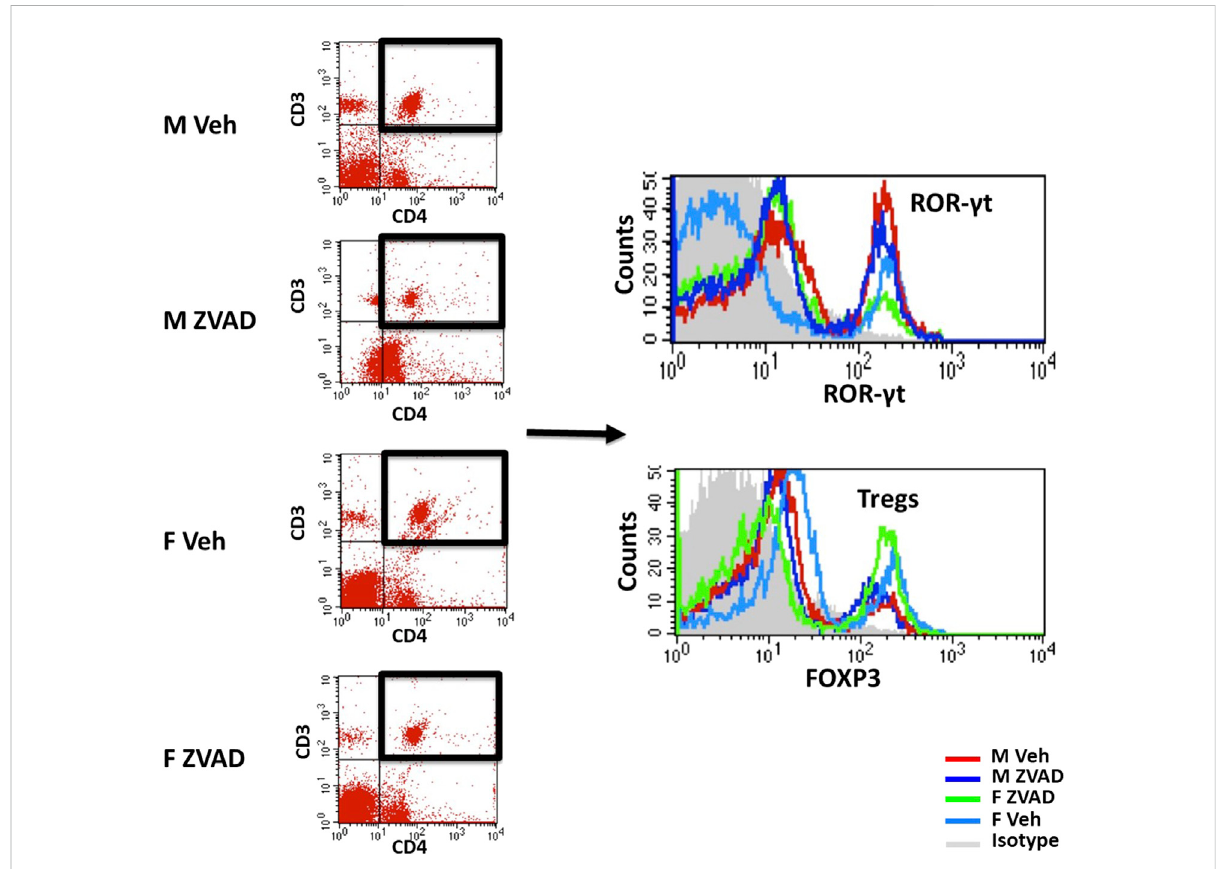
FIGURE 2 T cell pro fi les were analyzed by fl ow cytometry. Shown are representative scatterplots of fl ow cytometry gating strategy showing the selection of single cells and exclusion of cell debris based on forward scatter and side scatter. T cells were analyzed based on the expression of CD3 and/or CD4. Total CD3 + CD4 + T cells were further gated for expression of ROR- γ t for T helper 17 cells or Foxp3 for